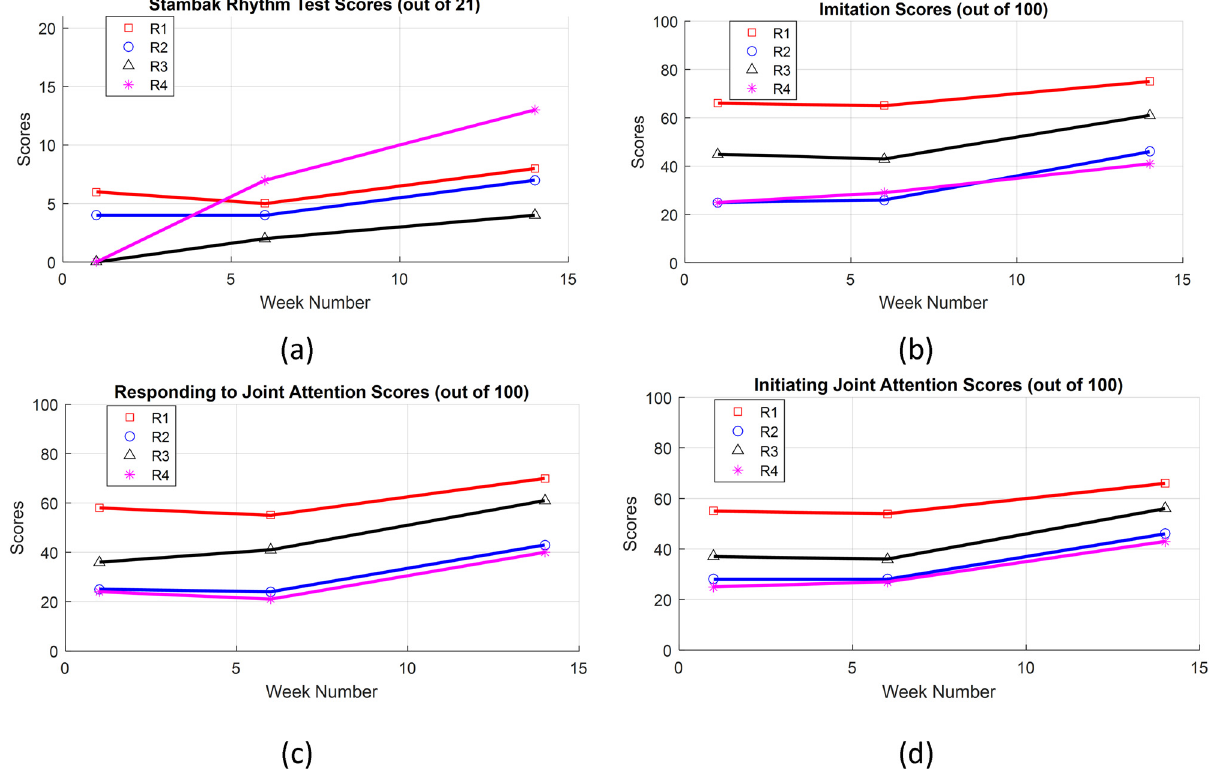
Figure 5: The results of the developmental assessments sessions for the LF subjects in the Baseline ( Week #1 ) , Pre - Test ( Week #6 ) , and the Post - Test ( Week #14 ) : ( a ) Stambak Rhythm Test, ( b ) imitation success percentage scores, ( c ) RJA scores, and ( d ) IJA